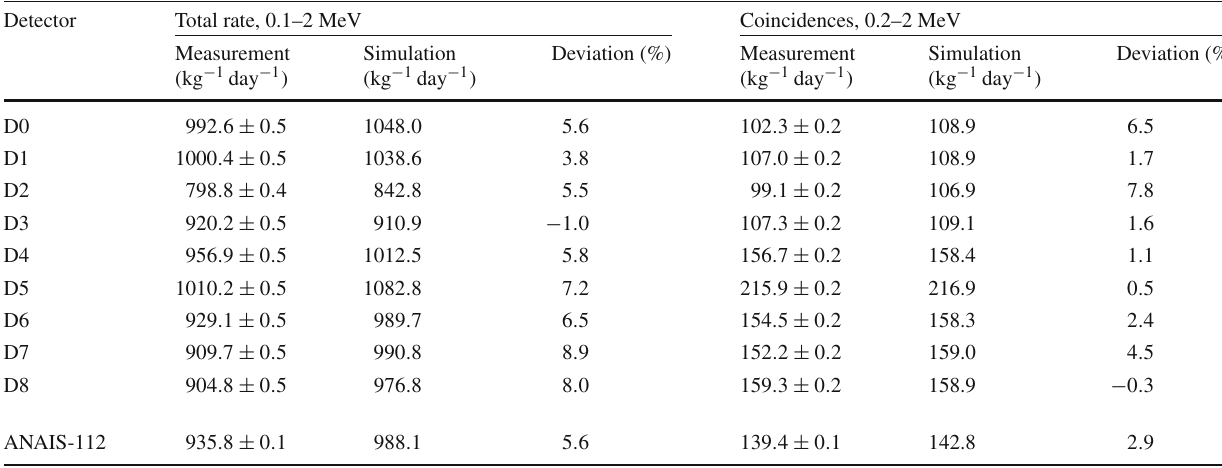
Table 8 Measured total rates (from Fig. 8) and rates of coincidences (from Fig. 9) up to 2 MeV for each ANAIS-112 detector and on average, from the first year of data taking. The corresponding simulated rates and their deviation from the measurement are also presented (see